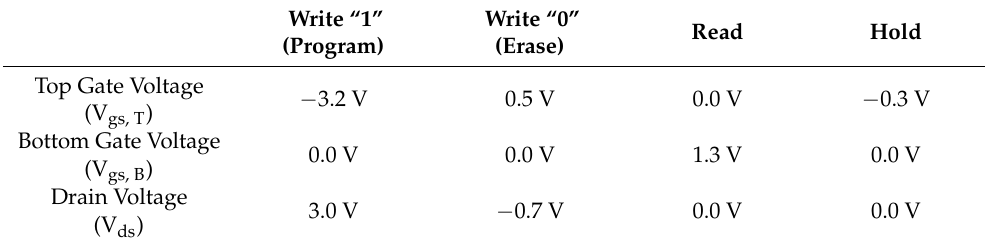
Table 2. Operating bias scheme for memory performance.